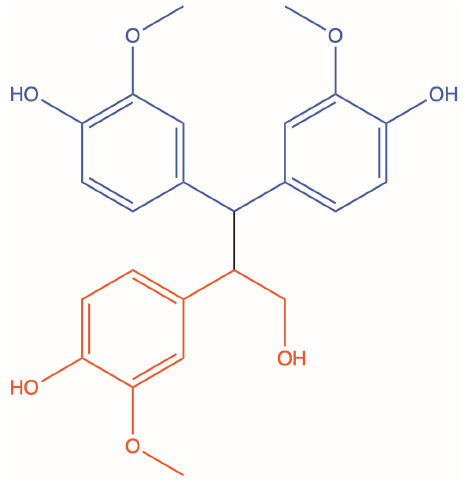
Figure 6. North and South substructures of quebecol. The North substructure is colored in blue, and the South substructure is colored in red.